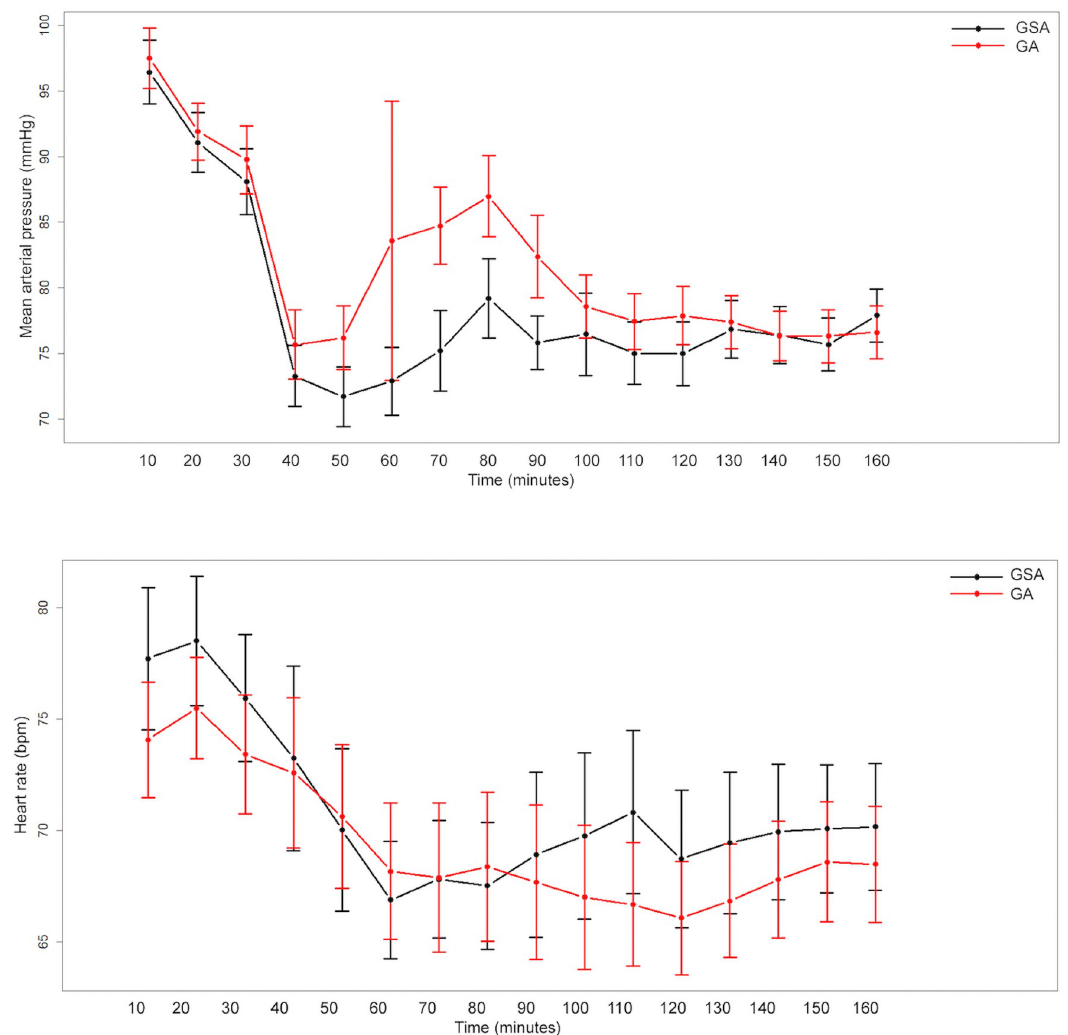
Fig 2. Hemodynamic parameters evaluated over time in both groups of patients. GA—general anesthesia; GSA—general anesthesia plus spinal block. (Hosmer-Lemeshow test: χ 2 (8) = 6.374; p = 0.606) (Fig 3), and discriminatory power (AUC 0.841, 95% CI 0.762–0.921) were adequate (Fig 4).